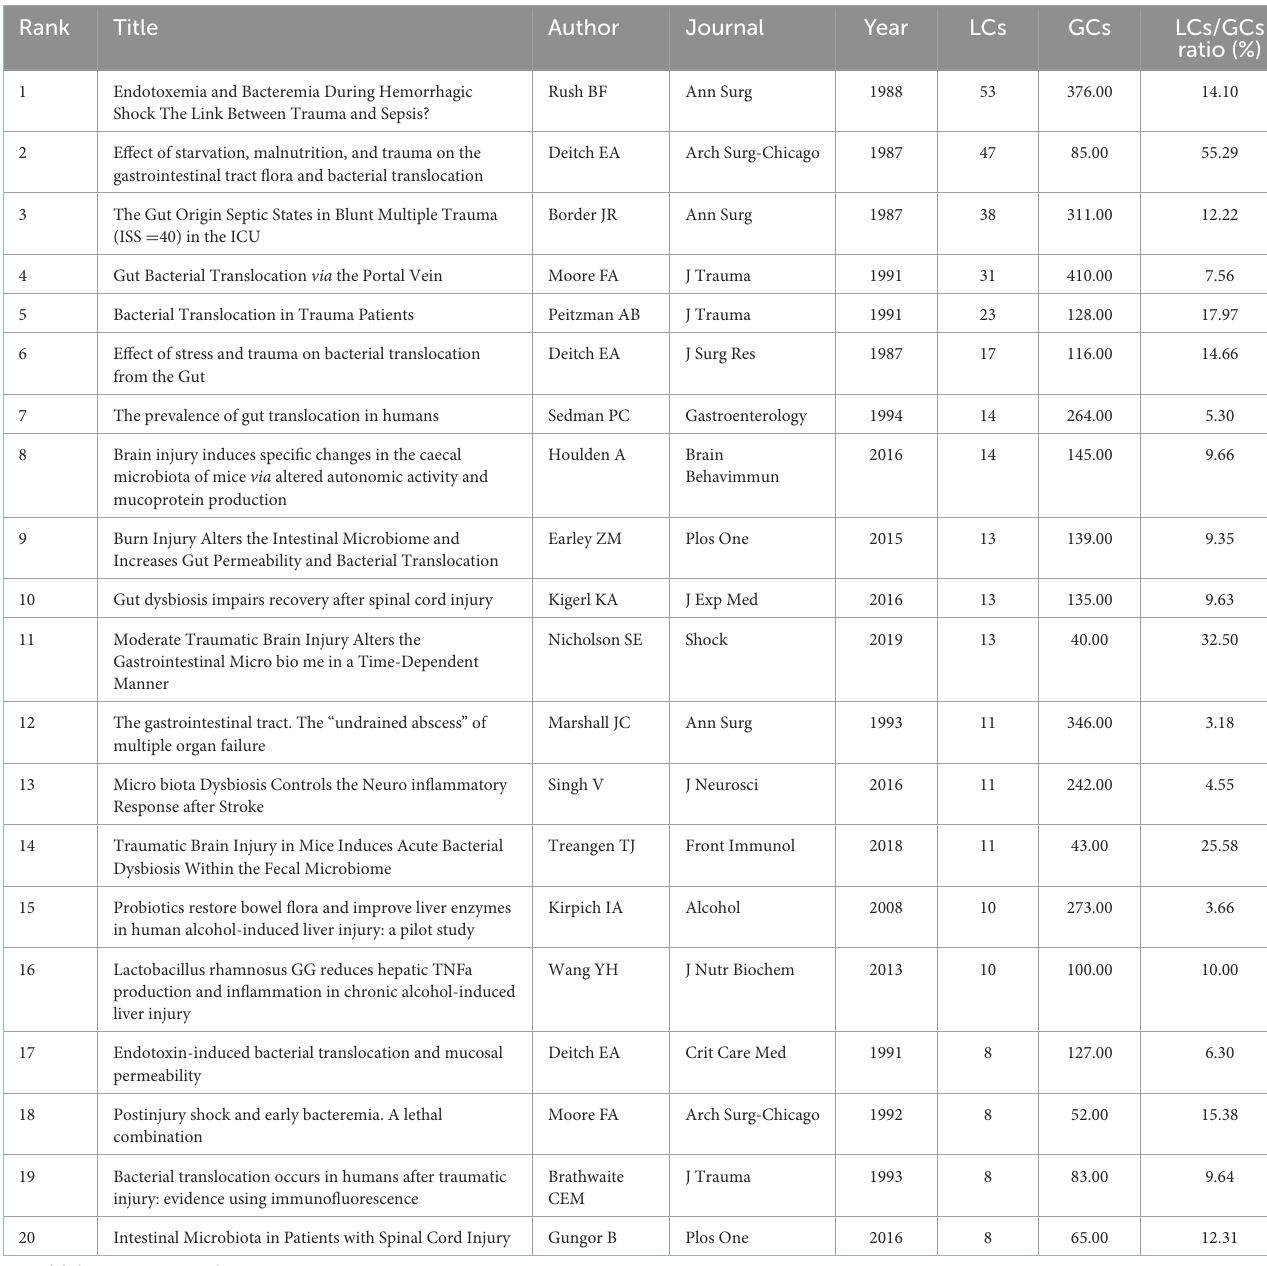
TABLE 4 Top 20 most local cited publications for burn and trauma associated with RBPs